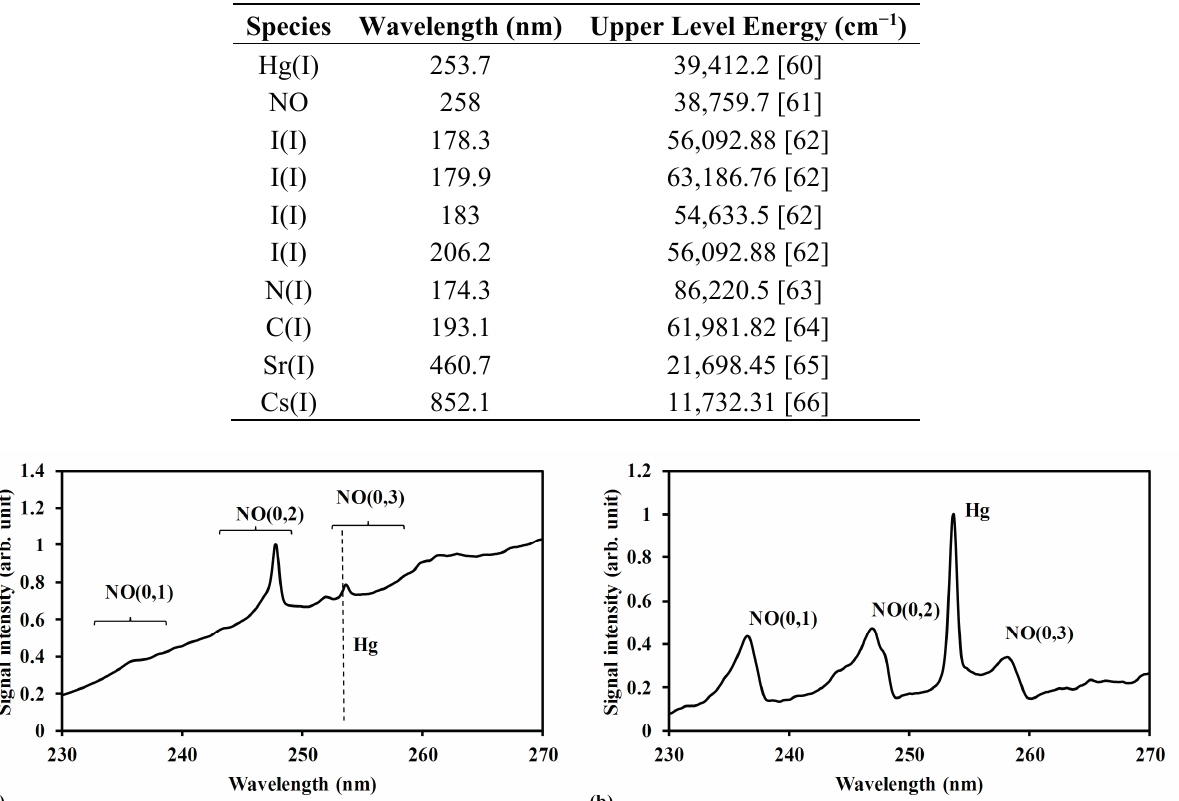
Table 3. Upper level energy of measured species.